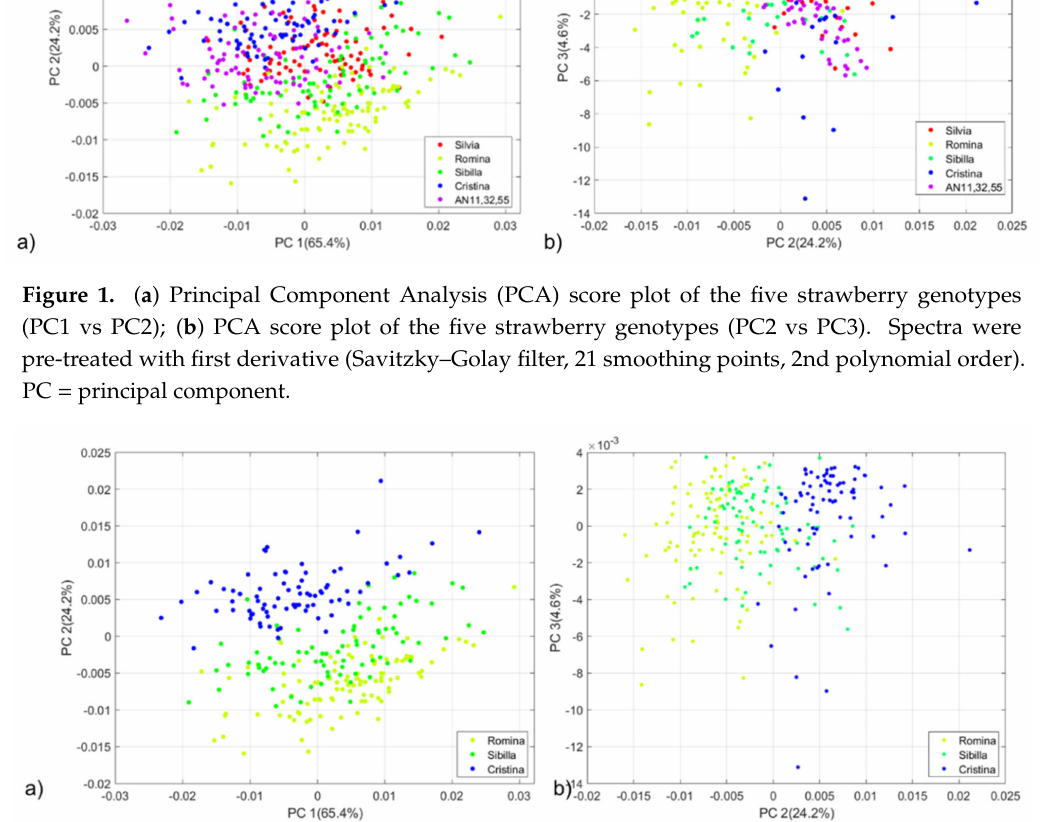
Figure 2. ( a ) PCA score plot of the Romina, Sibilla and Cristina cultivars (PC1 vs PC2). ( b ) PCA score plot of Romina, Sibilla and Cristina cultivars (PC2 vs PC3). Spectra were pre-treated with first derivative (Savitzky-Golay filter, 21 smoothing points, 2nd polynomial order). PC = principal component. To interpret the data and figure out which wavelengths are responsible for the sample